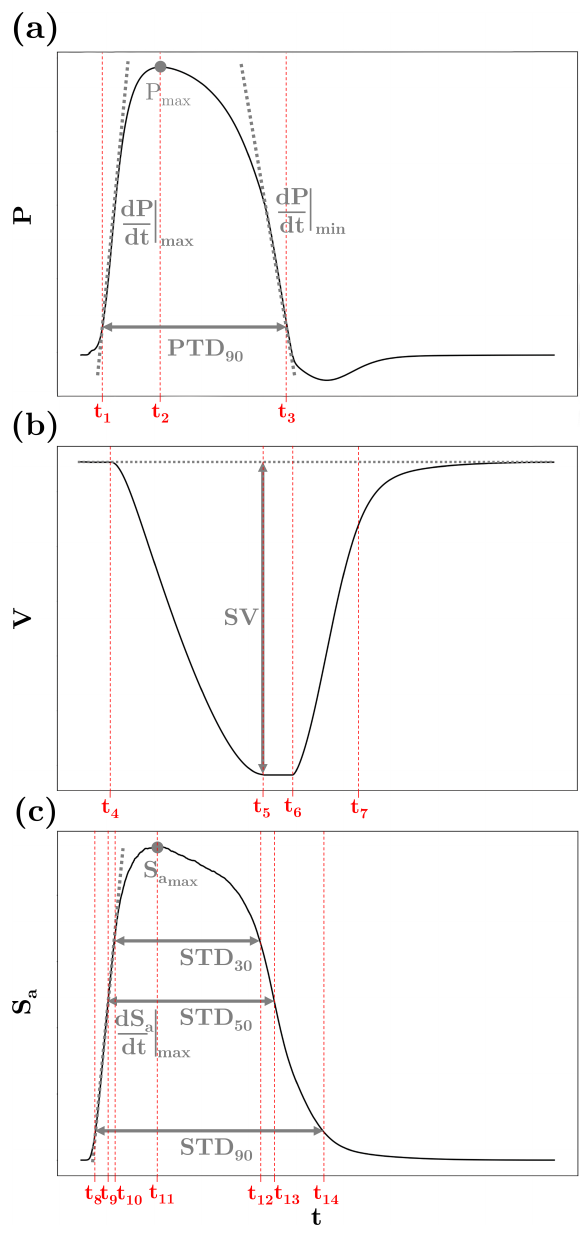
Figure A1. Biomarker definition and critical time points. ( a ) Pressure biomarkers, ( b ) volume biomarkers, and ( c ) active stress